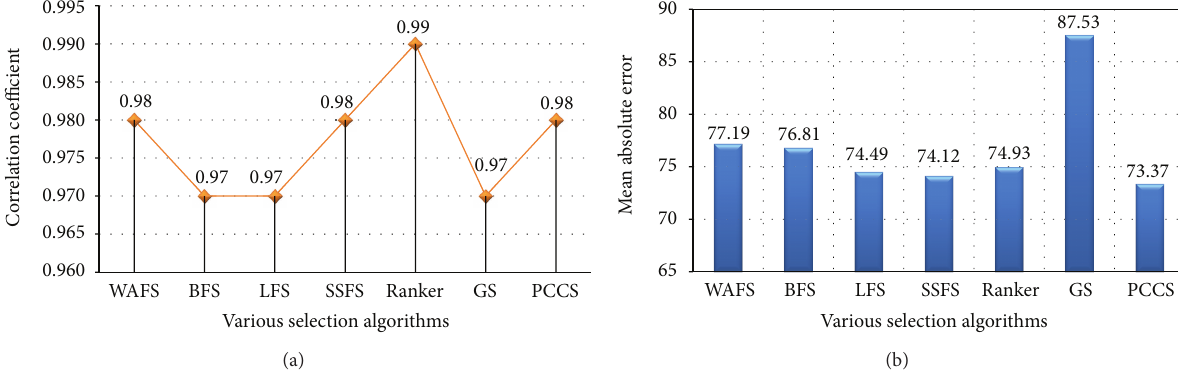
Figure 4: Effects of applying and without applying various feature selection algorithms on MLP (a) and LMS (b).